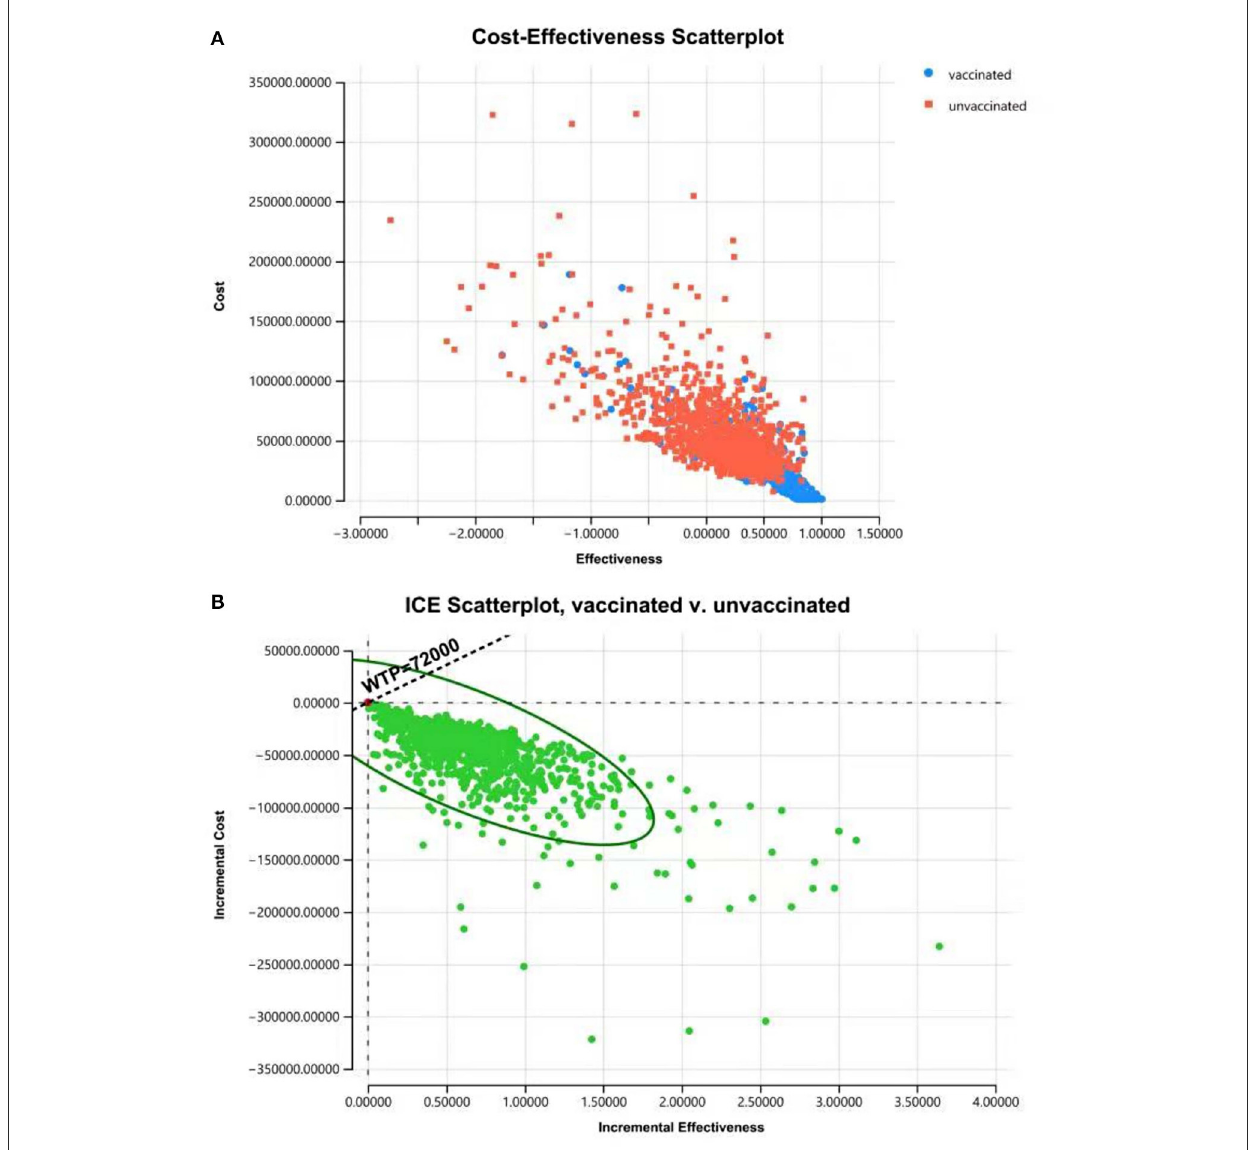
FIGURE7 Cost-effectiveness plane for cost and effective (A) and ICER (B) of “vaccinated” vs. “unvaccinated” produced from the PSA, indicating that vaccination is more effective and less costly with a probability of 97.9% when the WTP is 72,000 CNY per